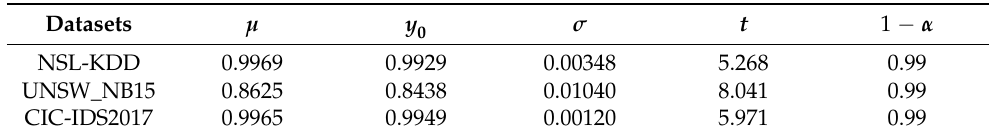
Table 14. Hypothesis test